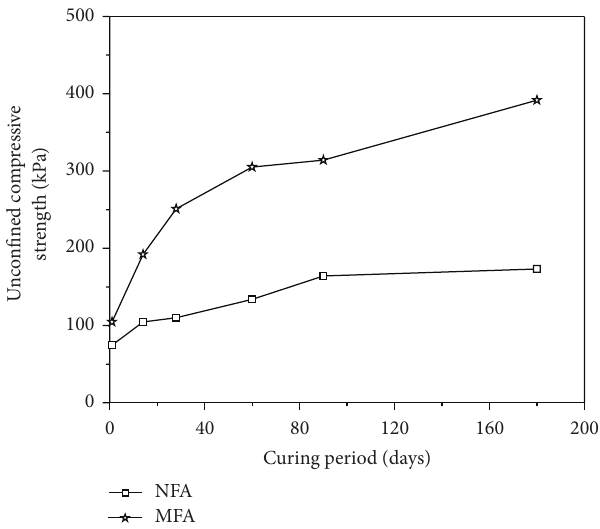
Figure7:Variationofunconfinedcompressionstrengthwithcuring period.